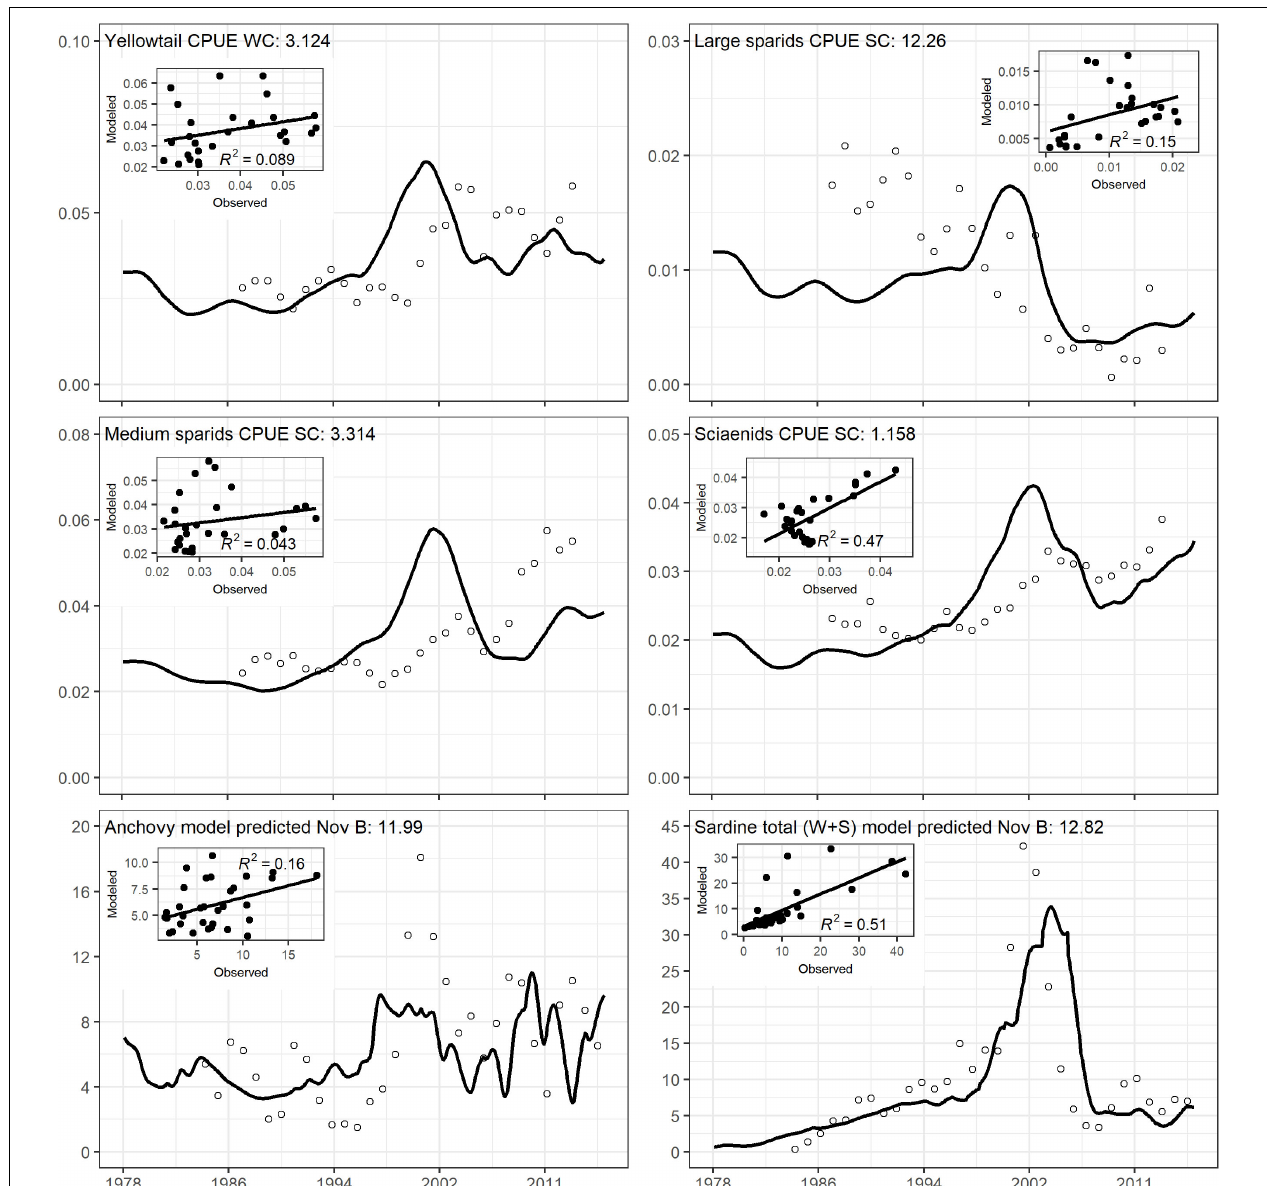
FIGURE 5 | Model fits of anchovy and sardine, and predators dependent on them in the preferred model fitting scenario. The contribution of each group to model sum of squares is provided on the plots. The figure is split into three sections to facilitate inclusion of scatterplots for each model-observation time series pair, and the R 2 of each correlation is